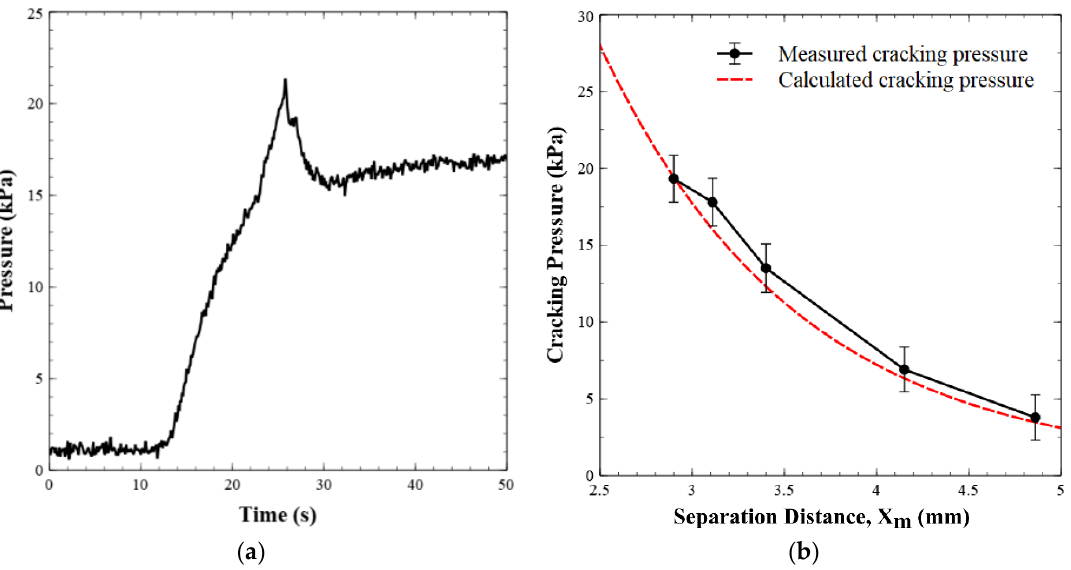
Figure 5. ( a ) Pressure profile of a valve as it opens under forward flow conditions. Milli-Q water is injected into the valve inlet at 0.05 mL min − 1 . Pressure increases until the point where it overcomes the magnetic pulling force on the steel ball. After the valve opens, flow occurs and pressure drops. ( b ) Experimental and calculated cracking pressures of the valve versus separation distance between the permanent magnet and the valve seat.